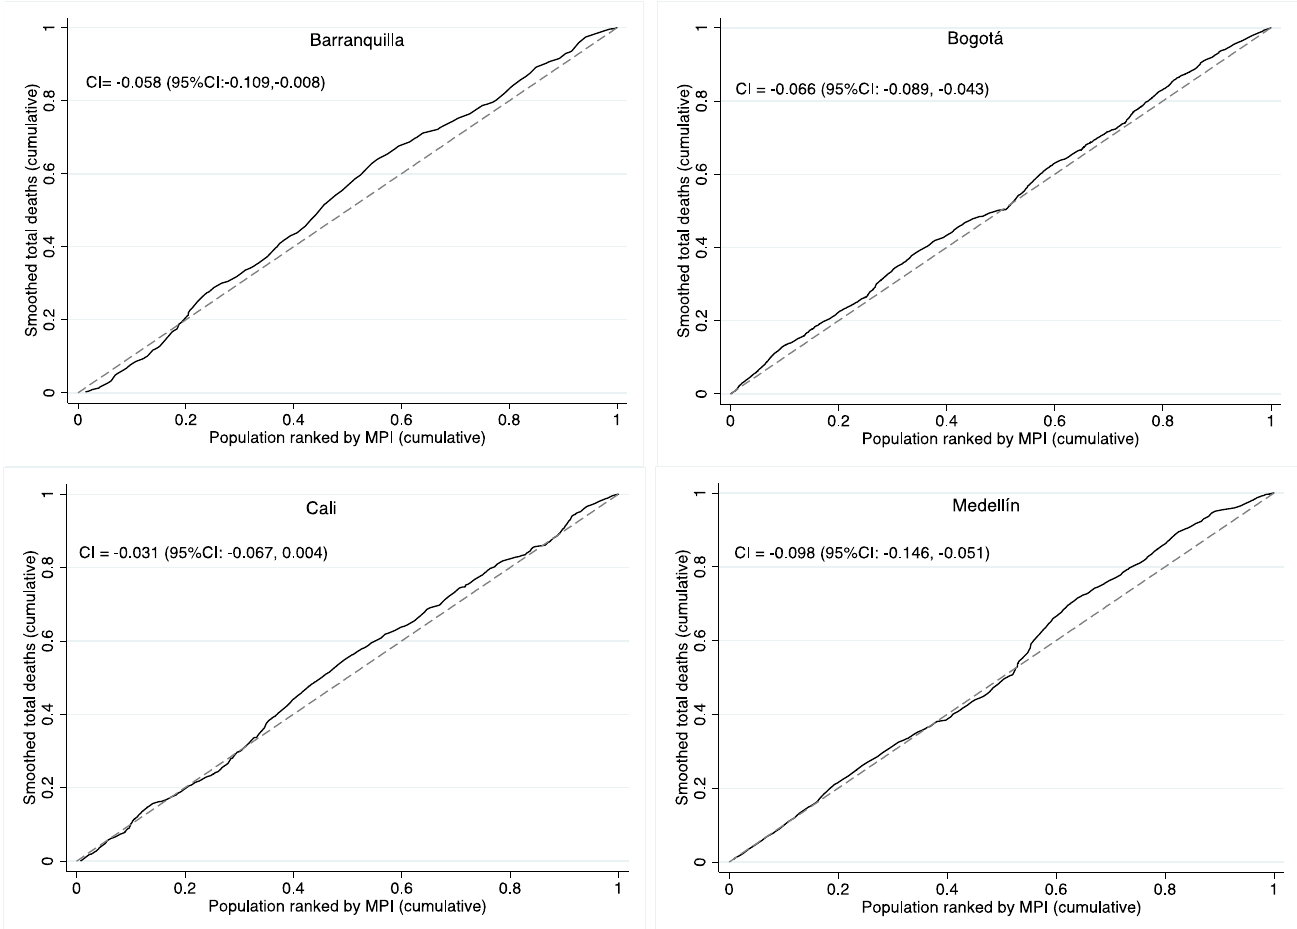
Figure 3. Concentration index (CInd) of mortality for all deaths by multidimensional poverty index (MPI) for four cities in Colombia, 2015–2019.